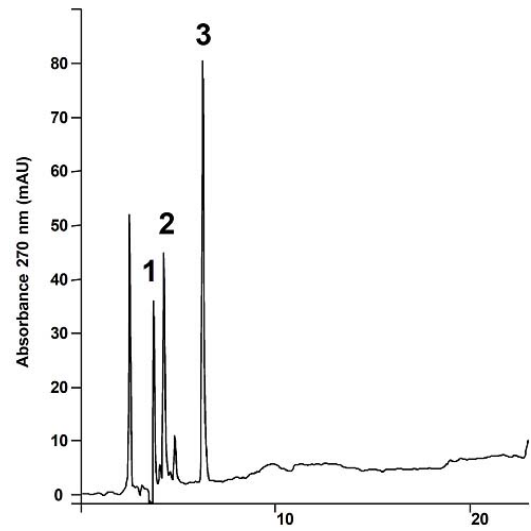
Figure 2. Analytical HPLC chromatogram of the compounds recorded at 270 nm: 1. rutin, = 3.70 ± 0.04 min); 2. 6-methoxyapigenin 7- O - β -D-glucopyranoside (T (T r min); 3. 6-methoxyapigenin (T = 6.72 ± 0.03 min). For the chromatographic r